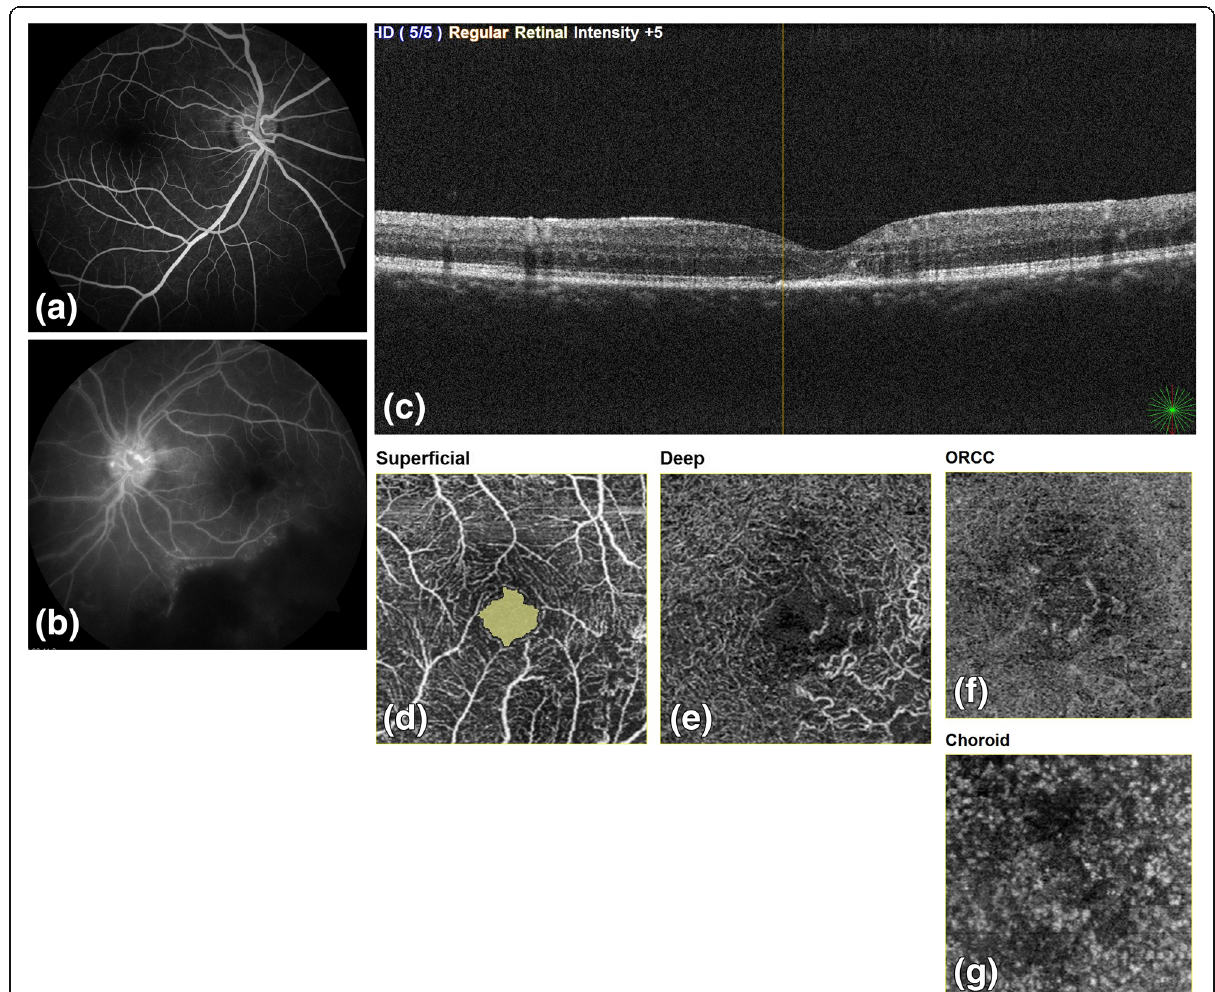
Fig. 5 22 years male vision left eye 6/18; (a) FA right eye: WNL (b) FA left eye macula appears WNL, capillary non perfusion encroaching posterior pole; FAZ appears normal (c) OCT: Few cystoid spaces and mild distortion of outer retinal layers (d) OCTA at SCP shows manually marked area of SCP: WNL (e) OCTA at DCP which is enlarged (f) OCTA at outer retina (g) OCTA at choroid